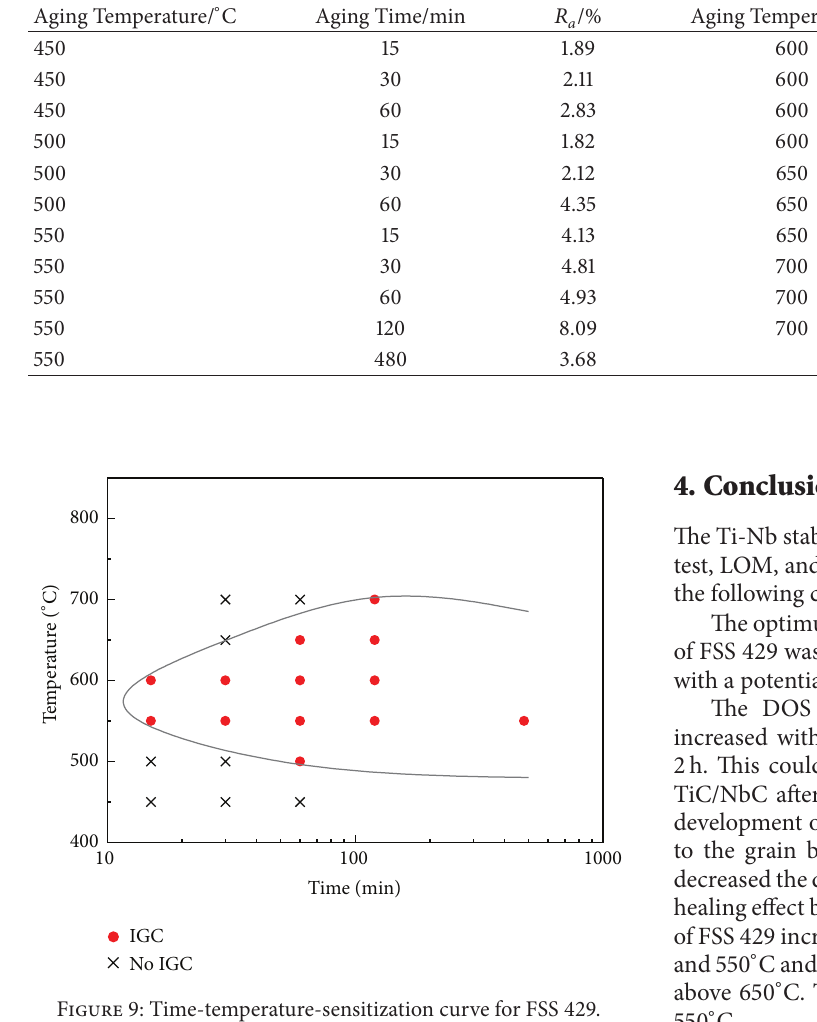
Figure 9: Time-temperature-sensitization curve for FSS